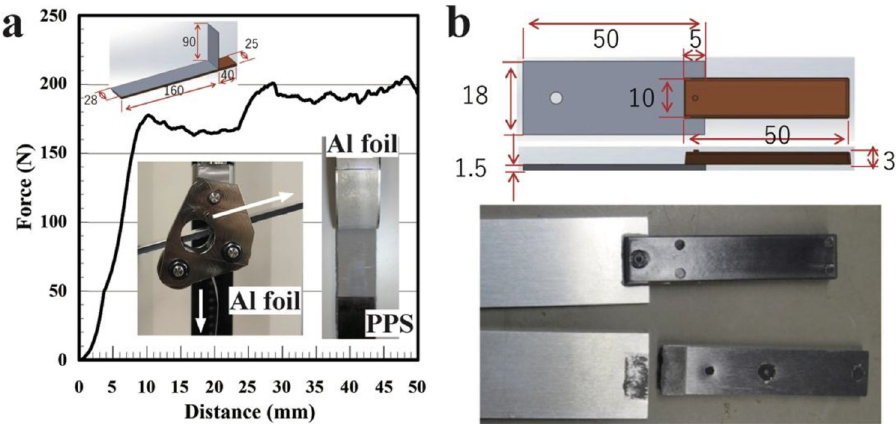
Fig. 10. (a) Force-distance curve obtained by the peeling resistivity test of Al/PPS laminate with NMT1 surface treatment. The specimen geometry, a specimen set in the fl oating roller jig, and the specimen after the test are shown therein. (b) The specimen geometry of the PPS/Al5052 lap joint, and the test specimens before and after the test.